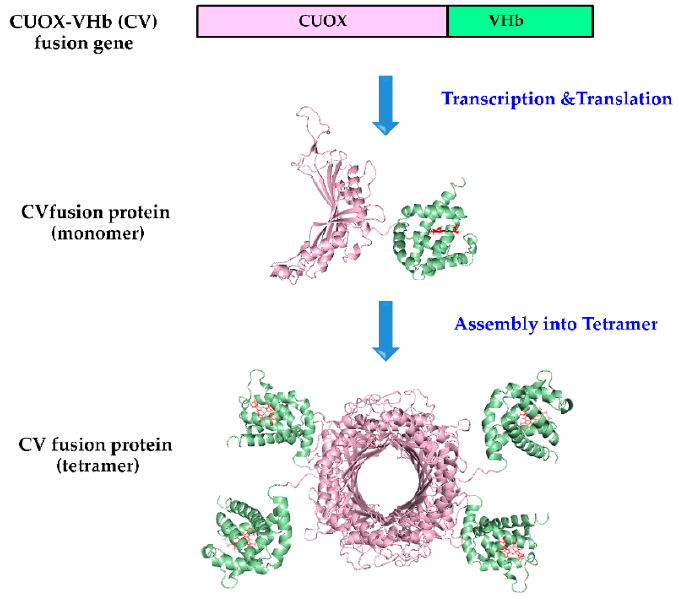
Figure 1. Schematic representation of the strategy for the engineering of bifunctional protein with uricase and peroxidase activities. In-frame fusion of Candida utilis uricase (CUOX) and Vitreoscilla hemoglobin (VHb) genes results in CUOX-VHb fusion protein, then, four monomers of the fusion protein assemble into a tetrameric complex. Construction of VHb-CUOX fusion protein was also performed by the same technique except that the VHb gene was put in front of the CUOX gene.